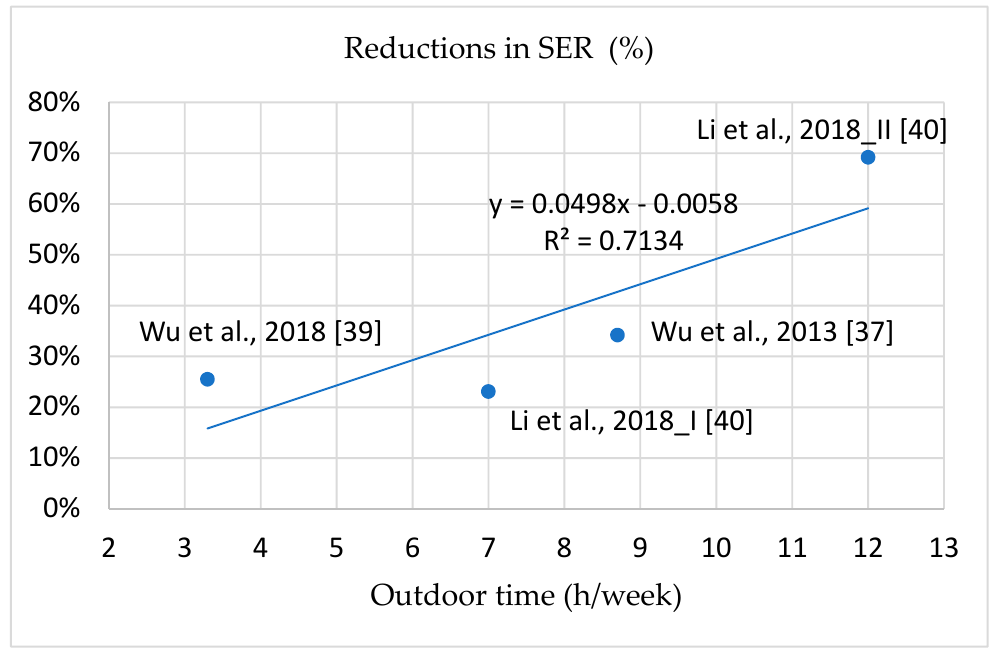
Figure 6. The dose-response effect between reduction ratios in SER and outdoor time at school.